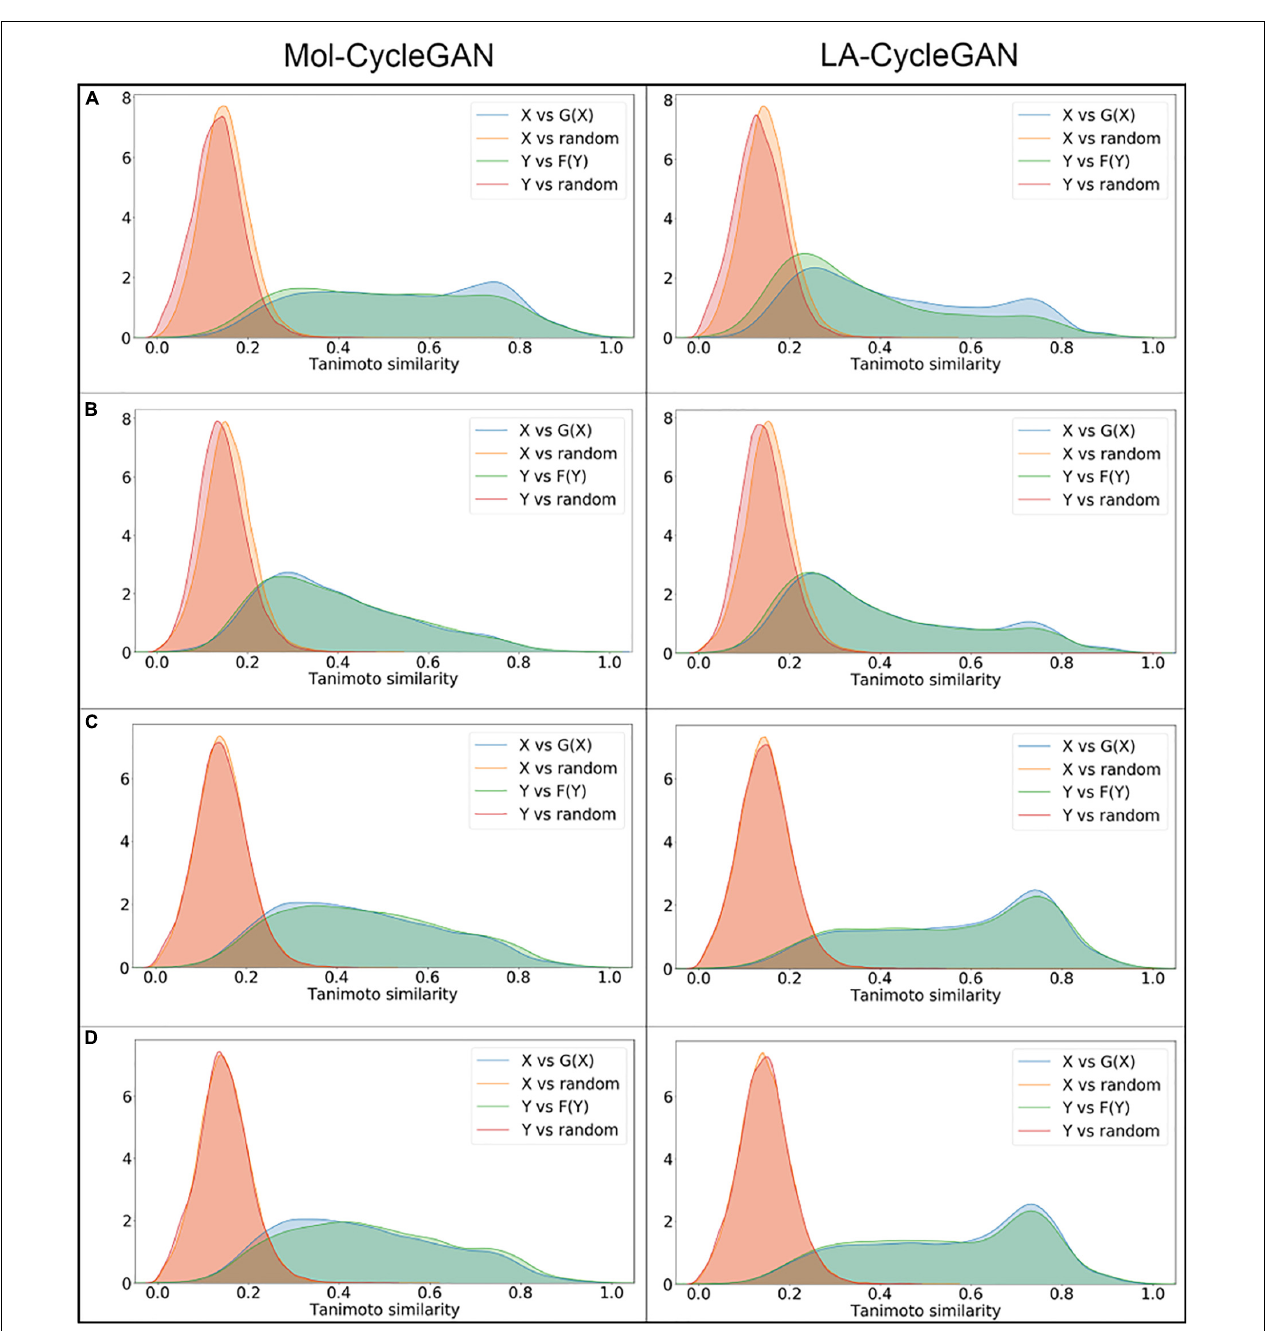
FIGURE 5 | Density map of Tanimoto similarity between corresponding molecules. (A) Tanimoto similarity for the Aliphatic Rings subset; (B) Tanimoto similarity for the Aromatic Rings subset; (C) Tanimoto similarity for the HBA subset; (D) Tanimoto similarity for the HBD subset. The left panel is from Mol-CycleGAN and the right panel is from